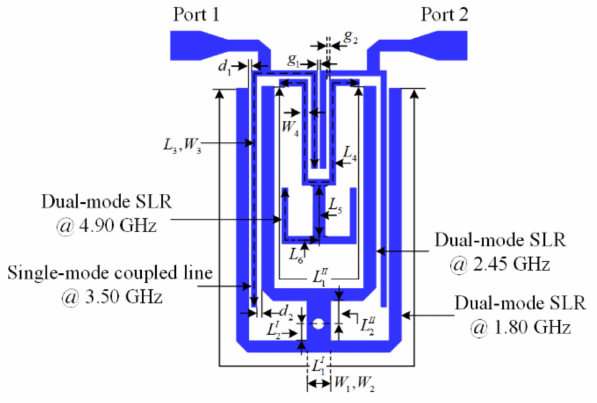
Figure 1. The layout of the proposed quad-band